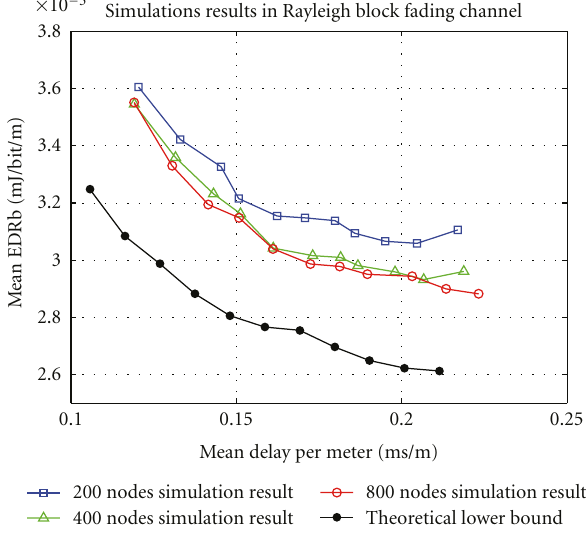
Figure 9: Mean number of relay candidates in di ff erent node